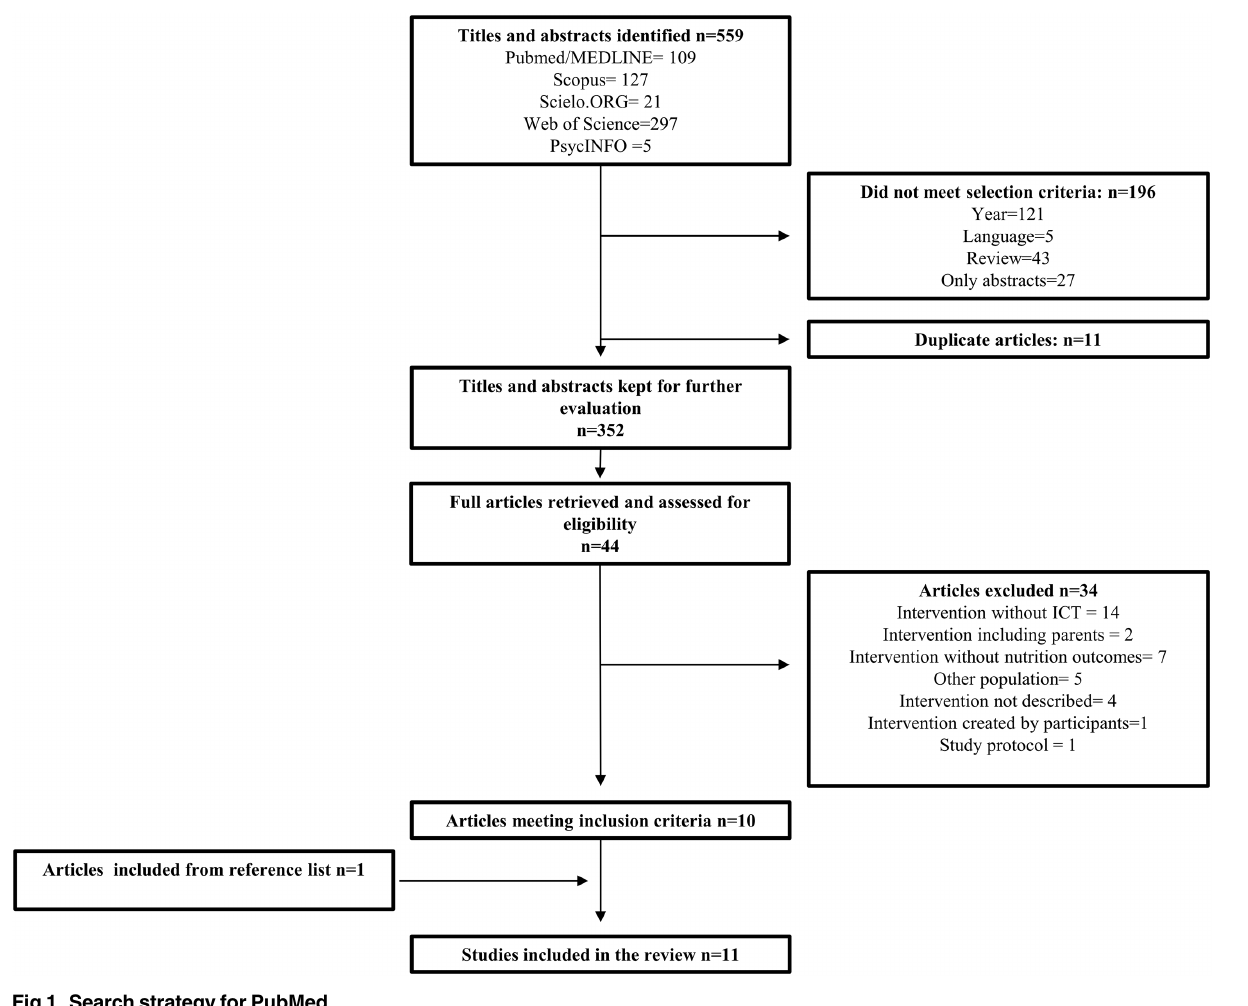
Fig 1. Search strategyfor